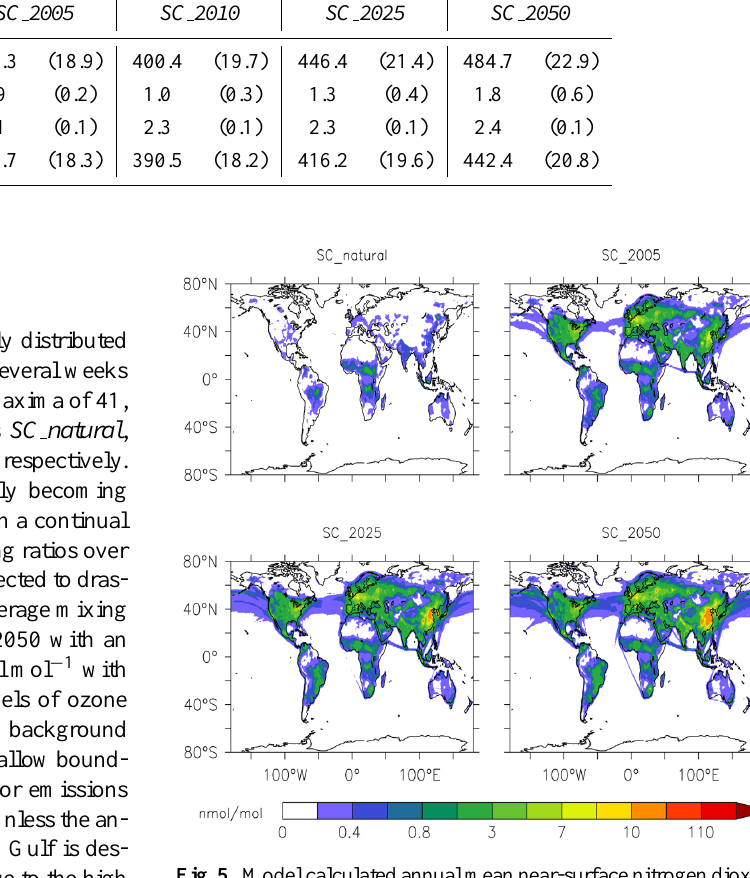
Table 3. Global burdens of CO , SO 2 , NO 2 and O 3 in Tg. The standard deviations due to the seasonal cycle are listed within parentheses. O 3 represents the tropospheric ozone, only integrated from the surface to the tropopause. species SC natural